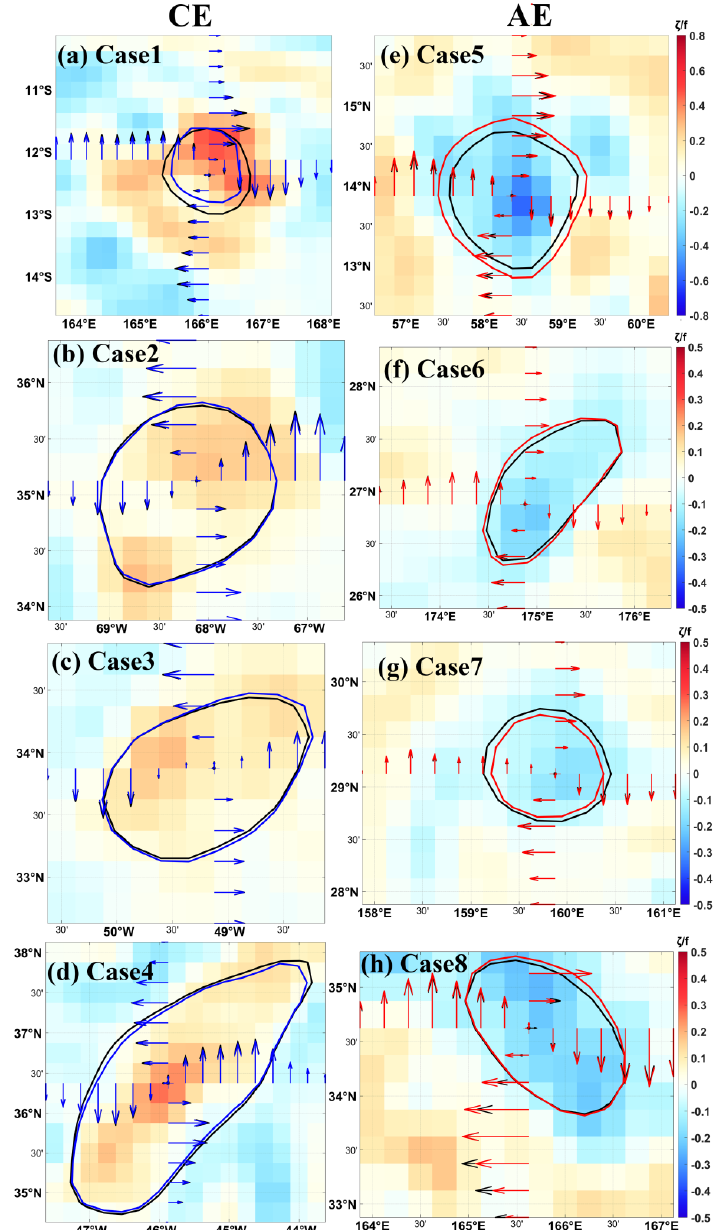
Figure 6. Comparison of the effect of cyclogeostrophic corrections on ( a – d ) cyclonic eddies and ( e – h ) anticyclonic eddies. The arrows in the figure are the zonal the meridional velocity anomaly components along the eddy radius. The circle is the eddy boundary (black represents the initial geostrophic current field, blue represents the cyclogeostrophic cyclonic eddy, and red represents the cyclogeostrophic anticyclonic eddy), and the background color is the cyclogeostrophic normalized relative vorticity.